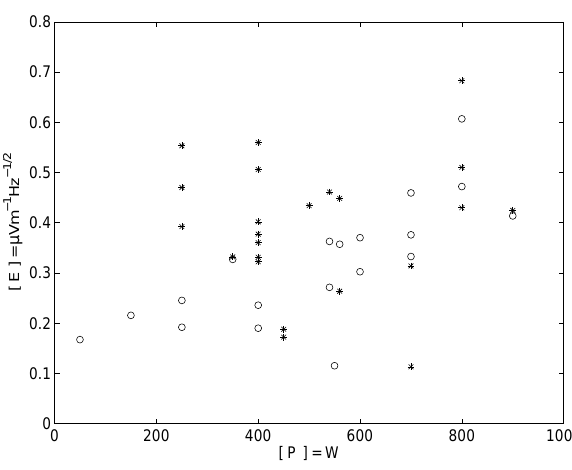
Fig. 5. The electric field intensities measured by the DEMETER satellite at ∼ 660km height are related to the power of the LO- RAN transmitters at high ( L > 2.14) geomagnetic latitudes (stars) and at low ( L < 2.14) geomagnetic latitudes (circles), but they ex- hibit a large variability as a result of the sub-ionospheric propaga- tion and ducting along the geomagnetic field lines. The electric field intensities at low latitudes appear to be less variable as a result of the shorter radio wave propagation distance along the geomag- netic field lines. The smaller variability may also be related to the more efficient sideways trapping of radio waves by the ducts form- ing along geomagnetic field lines which have a smaller inclination at low latitudes as compared to high